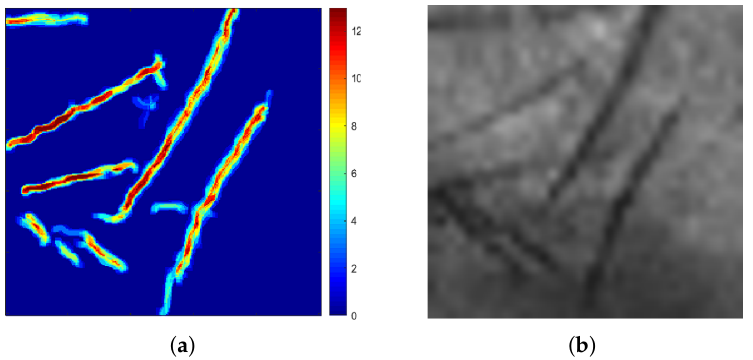
Figure 4. ( a ) Three-dimensional template represented as a colour scale matrix where the trait’s depth varies from 0 to 13; ( b ) 2D greyscale render of the same